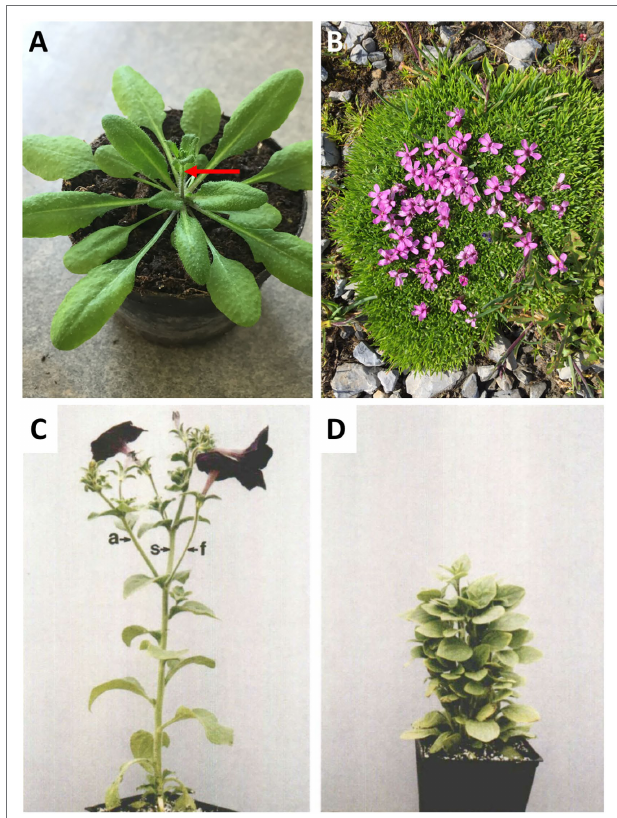
FIGURE 1 | Apical dominance. (A) Apical dominance in the pioneer plant Arabidopsis thaliana at the onset of flowering. (B) The alpine plant Silene acaulis exhibits very low apical dominance. It exhibits a profusely branched shoot, in which no main shoot can be distinguished. (C,D) The model plant for apical dominance Petunia hybrida V26, and the isogenic mutant decreased apical dominance1 ( dad1 ). The pleiotropic phenotype includes short stature, high branching, and late flowering ( C,D , with permission from Napoli,